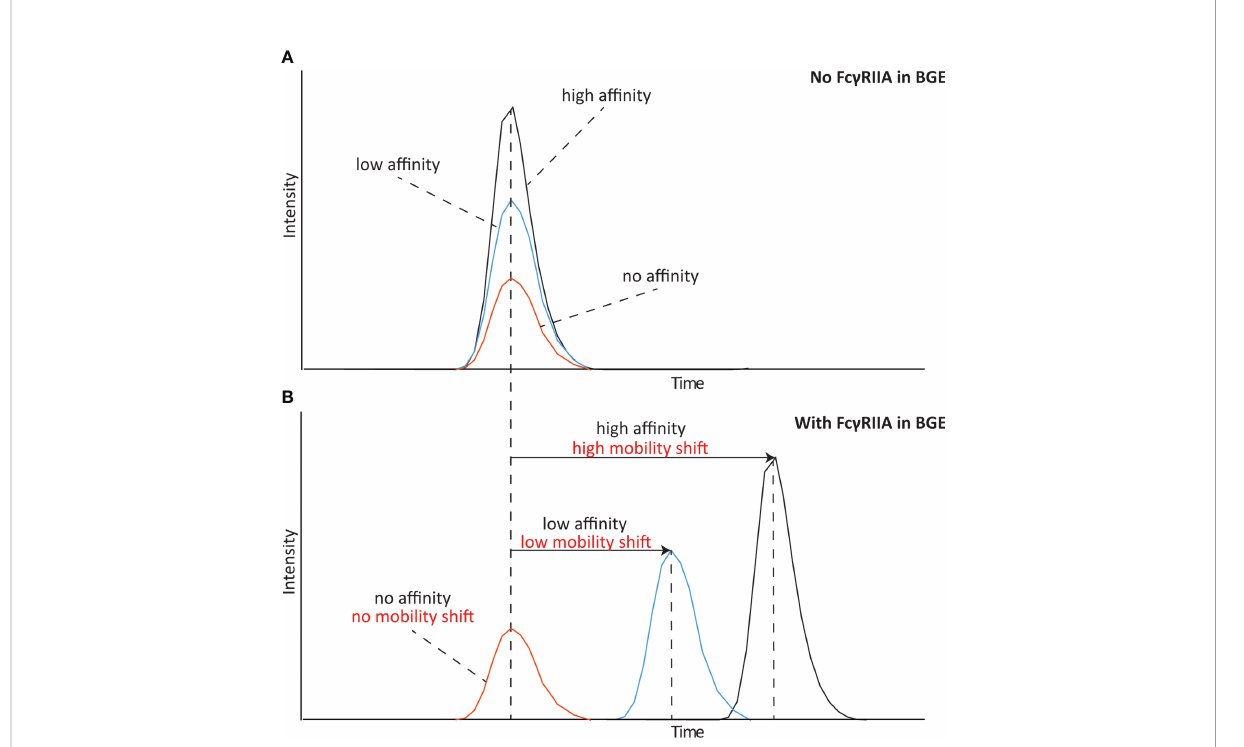
FIGURE 1 Schematical representation of an mobility shift af fi nity CE experiment analyzing species with high, low and no af fi nity to the receptor. (A) Af fi nity CE analysis without any Fc g RIIa in the background electrolyte (BGE) and (B) analysis with Fc g RIIa in the